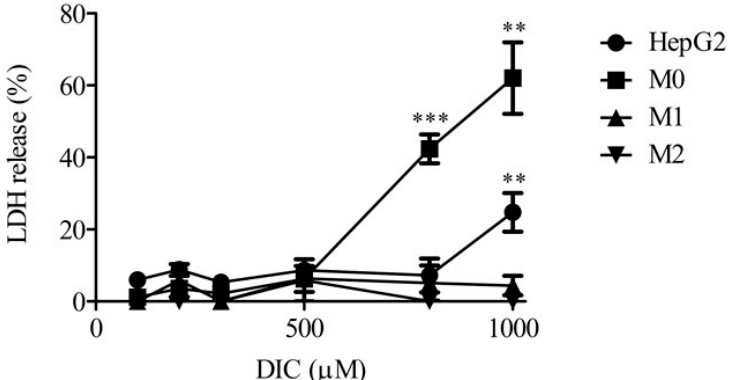
Figure 1. LDH release in HepG2, M0, M1, or M2 alone 24 h after DIC treatment (100, 200, 300, 500, 800, and 1000 μ M). The results are expressed as the mean ± SE of each group (n = 3–6). Significant differences (** p < 0.01 and *** p < 0.001 vs. DIC (100 μ M)) were observed.